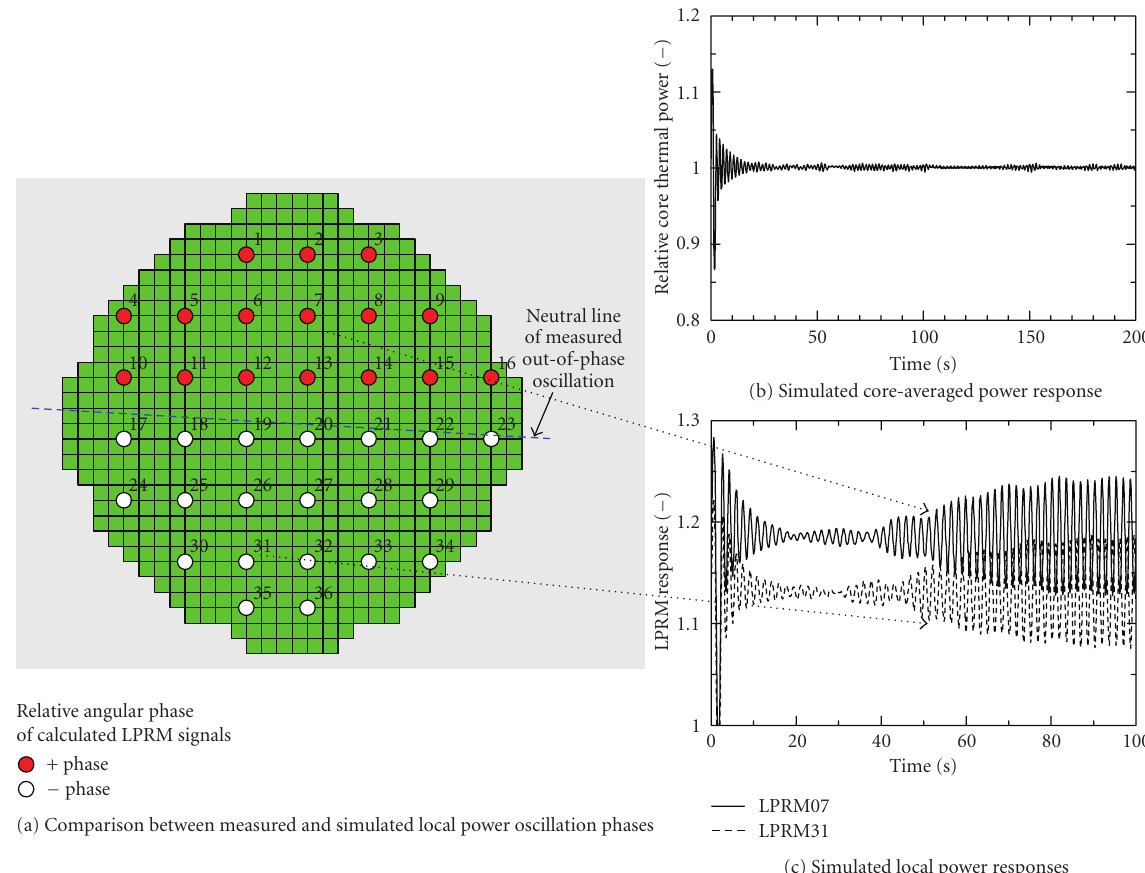
Figure 7: Simulated regional instability at Ringhals-1 C14/PT9 stability test.